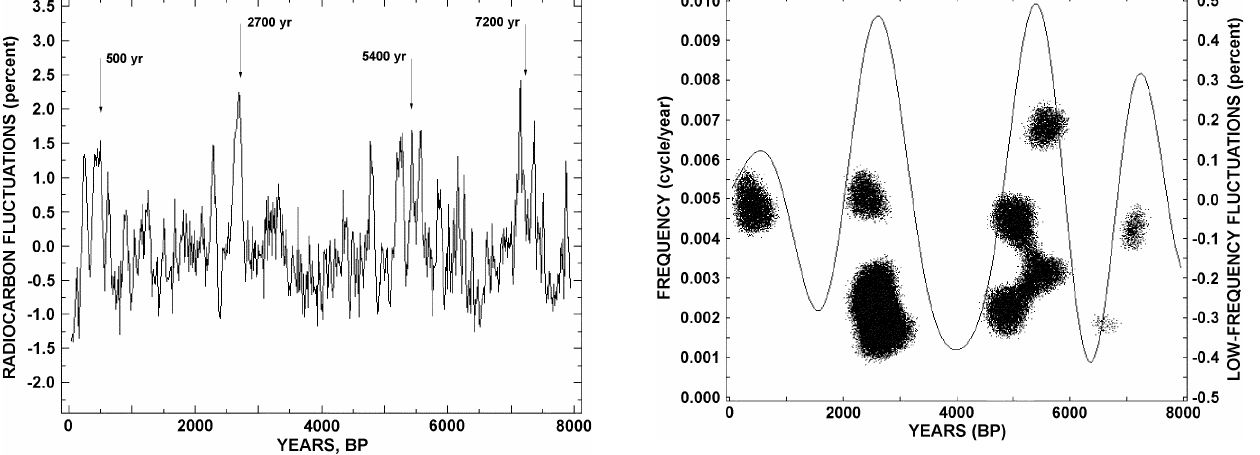
Fig. 1. Radiocarbon series 1 14 C D in time after long-term detrend- ing. The strongest fluctuations occurred at 500, 2700, 5400 and 7200 years BP (before present).